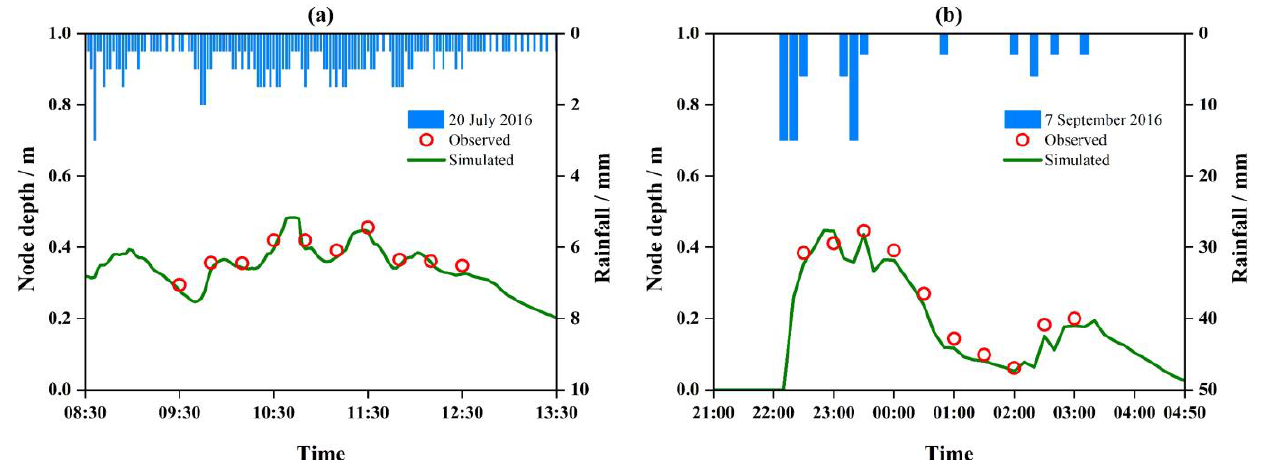
Figure 2. Simulated (green lines) and observed (red circles) hydrographs at drainage node J20 for two rainfall events (blue bars) during the monitoring periods: ( a ) 20 July 2019 rainfall event and ( b ) 7 September 2016 rainfall event.